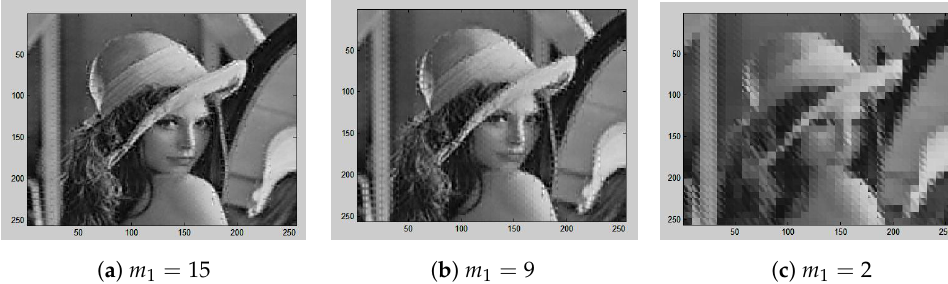
Figure 5. Visual evaluation of the performances corresponding to the DCT compression